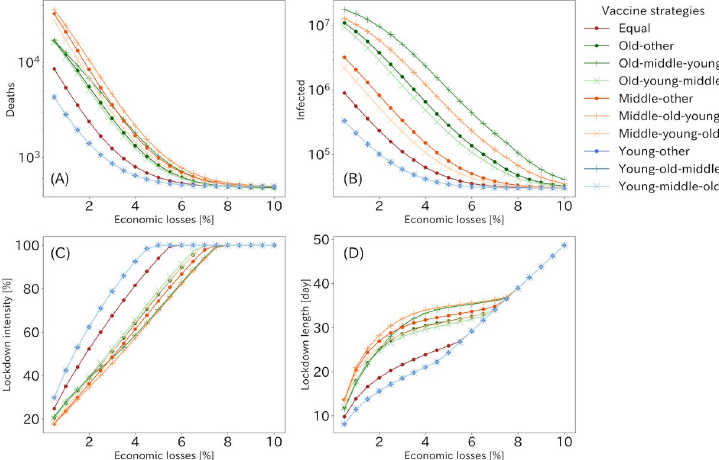
Fig 3. The optimized results and parameters for R0 = 1.3 and ϕ = 0 when the lockdown was imposed equally to each generation. The optimized results of the cumulative number of deaths (A) and infected (B) populations for each economic loss. (C) and (D) represents the lockdown intensity and length, which value pattern produced the results of (A) and (B) for each economic loss. Although there are only eight lines visible in (A) and (B), three lines of young first vaccination strategies have overlain each other. The order of age groups on the label shows vaccine allocation strategies.